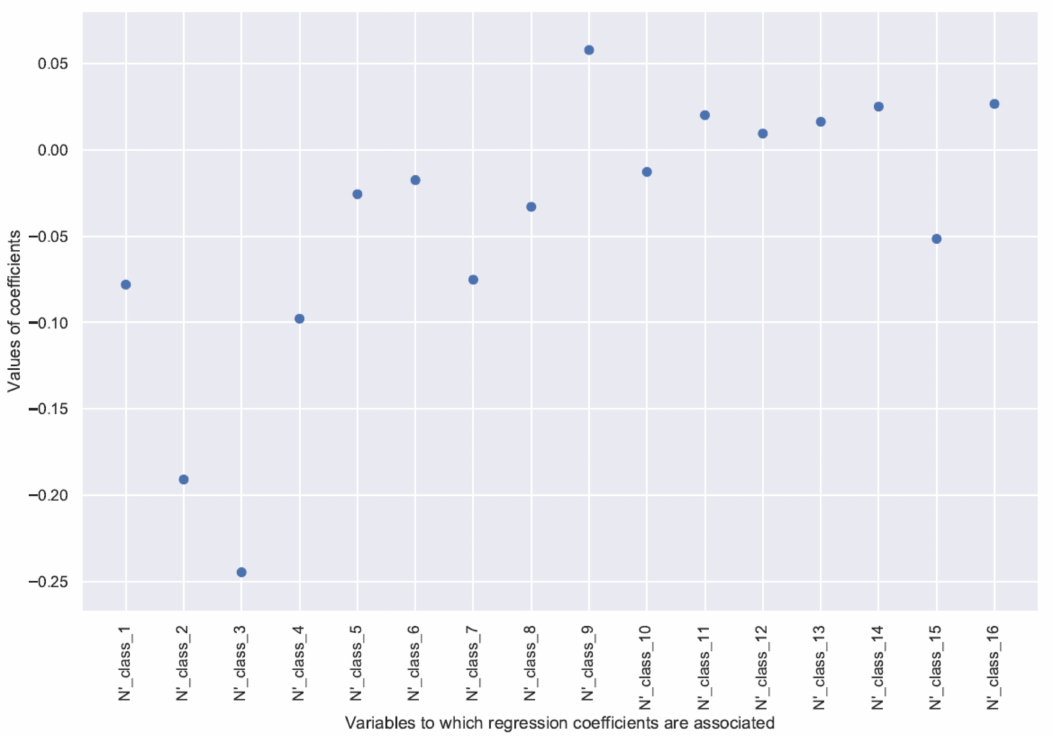
Figure 6. Regression coefficients for the model of diameter class 1, associated with transformed features N (cid:48) . d